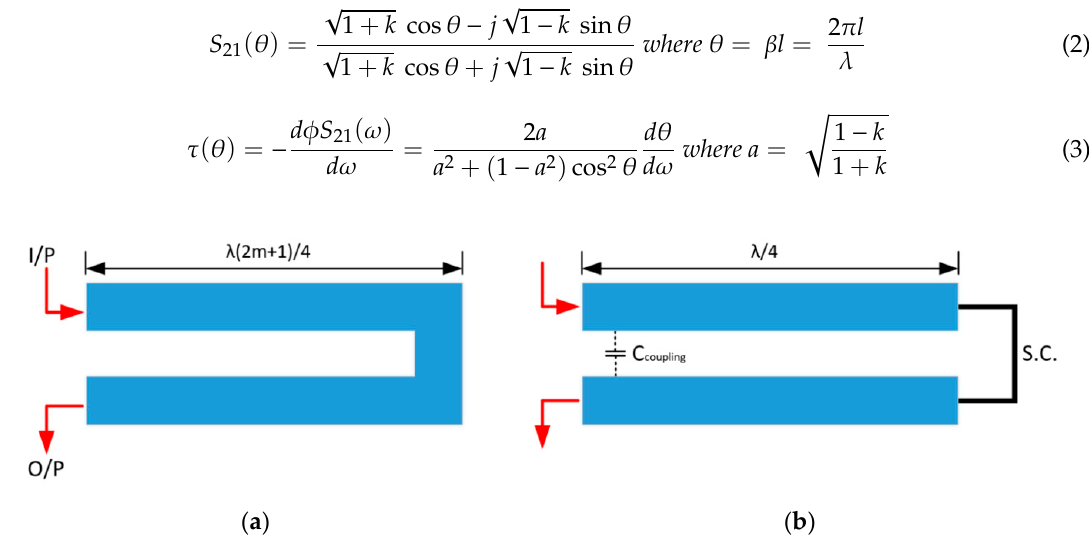
Figure 5. Hairpin Resonator ( a ) and Equivalent Circuit ( b )—Adapted from Reference [53]